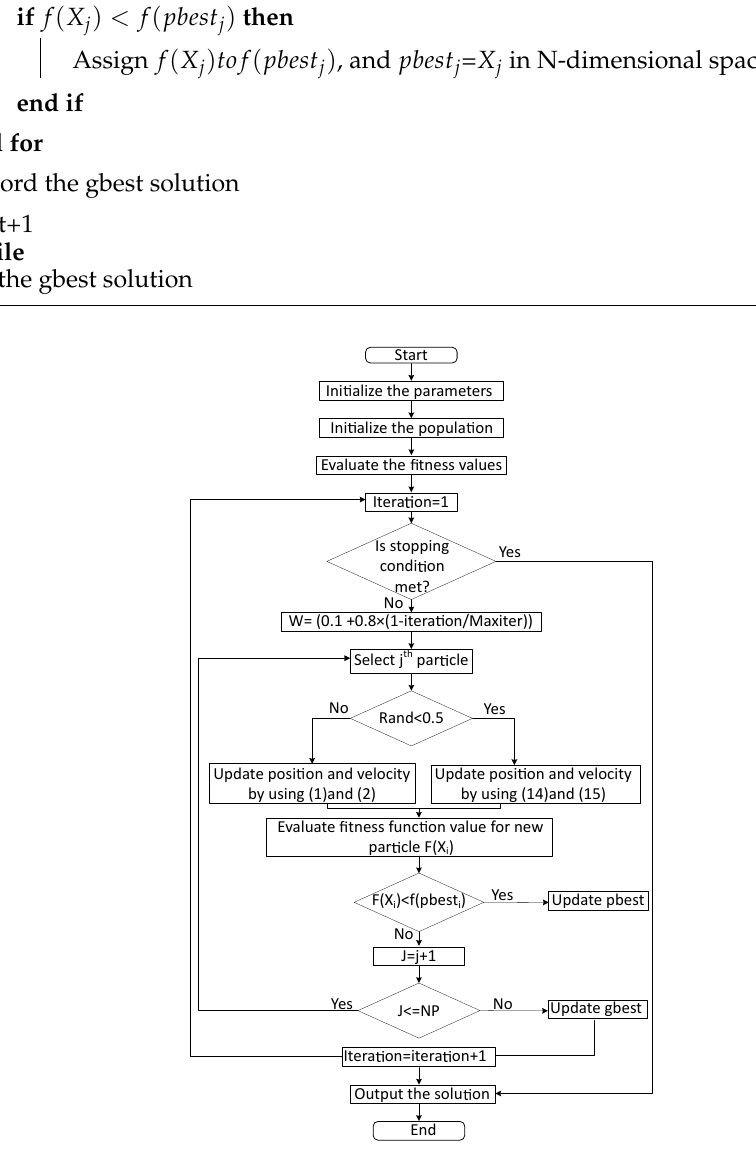
Figure 4. Flowchart of